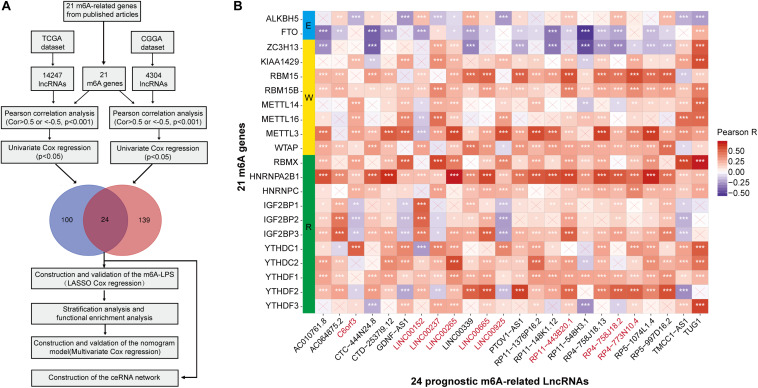
(A) Study flow chart. (B) Heatmap of the correlations between m6A-related genes and the 24 prognostic m6A-related lncRNAs. *p < 0.05, **p < 0.01, and ***p < 0.001.